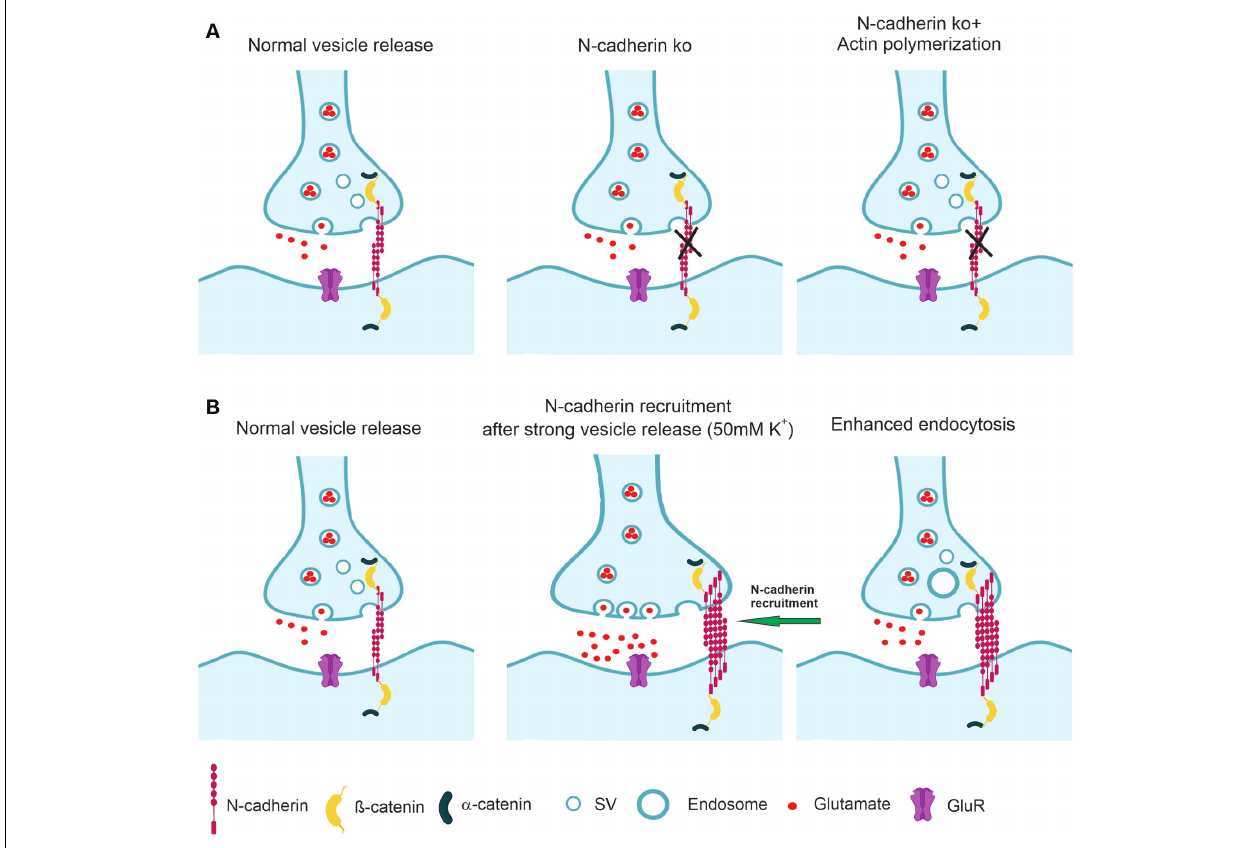
FIGURE 8 | Model of the regulation of synaptic vesicle endocytosis by N-cadherin. (A) At normal vesicle release, loss of N-cadherin at glutamatergic synapses leads to reduced synaptic vesicle endocytosis. Impaired endocytosis is ameliorated by pharmacologically enhancing actin polymerization. (B) At massive vesicle release induced by K + depolarization, additional N-cadherin is recruited to glutamatergic synapses. Enhanced N-cadherin clustering promotes more efficient endocytosis.